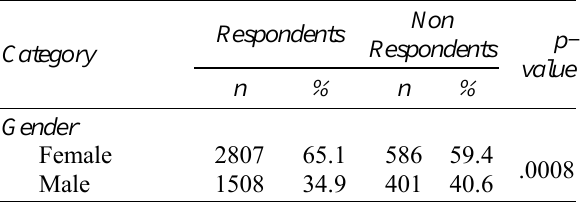
Table 1: Demographic Characteristics of